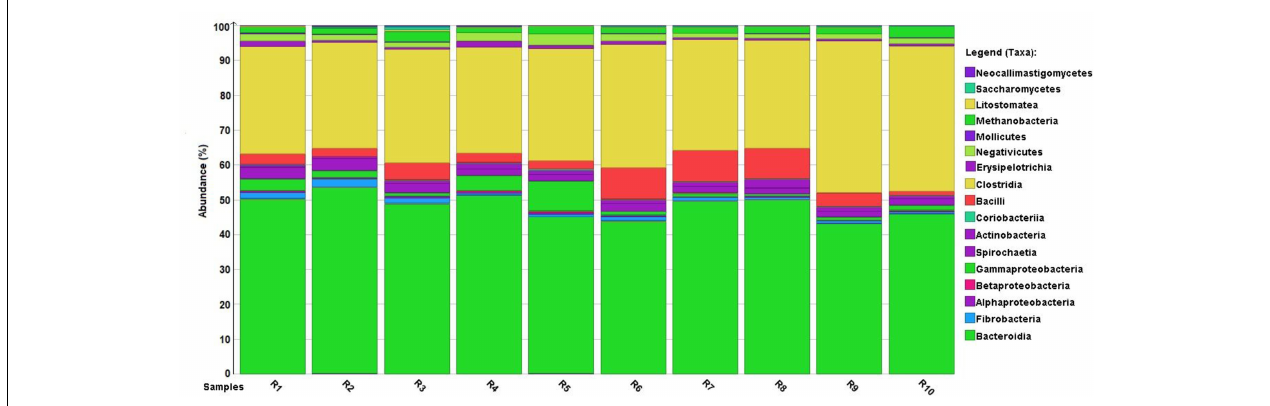
FIGURE 1 | Normalized distribution of metagenome reads among Bacteria classes. Although the absolute number of reads ( Supplementary Table S2 ) varied among individual rumen samples (R1–R10), the normalized values indicate a fairly consistent distribution of major taxa.